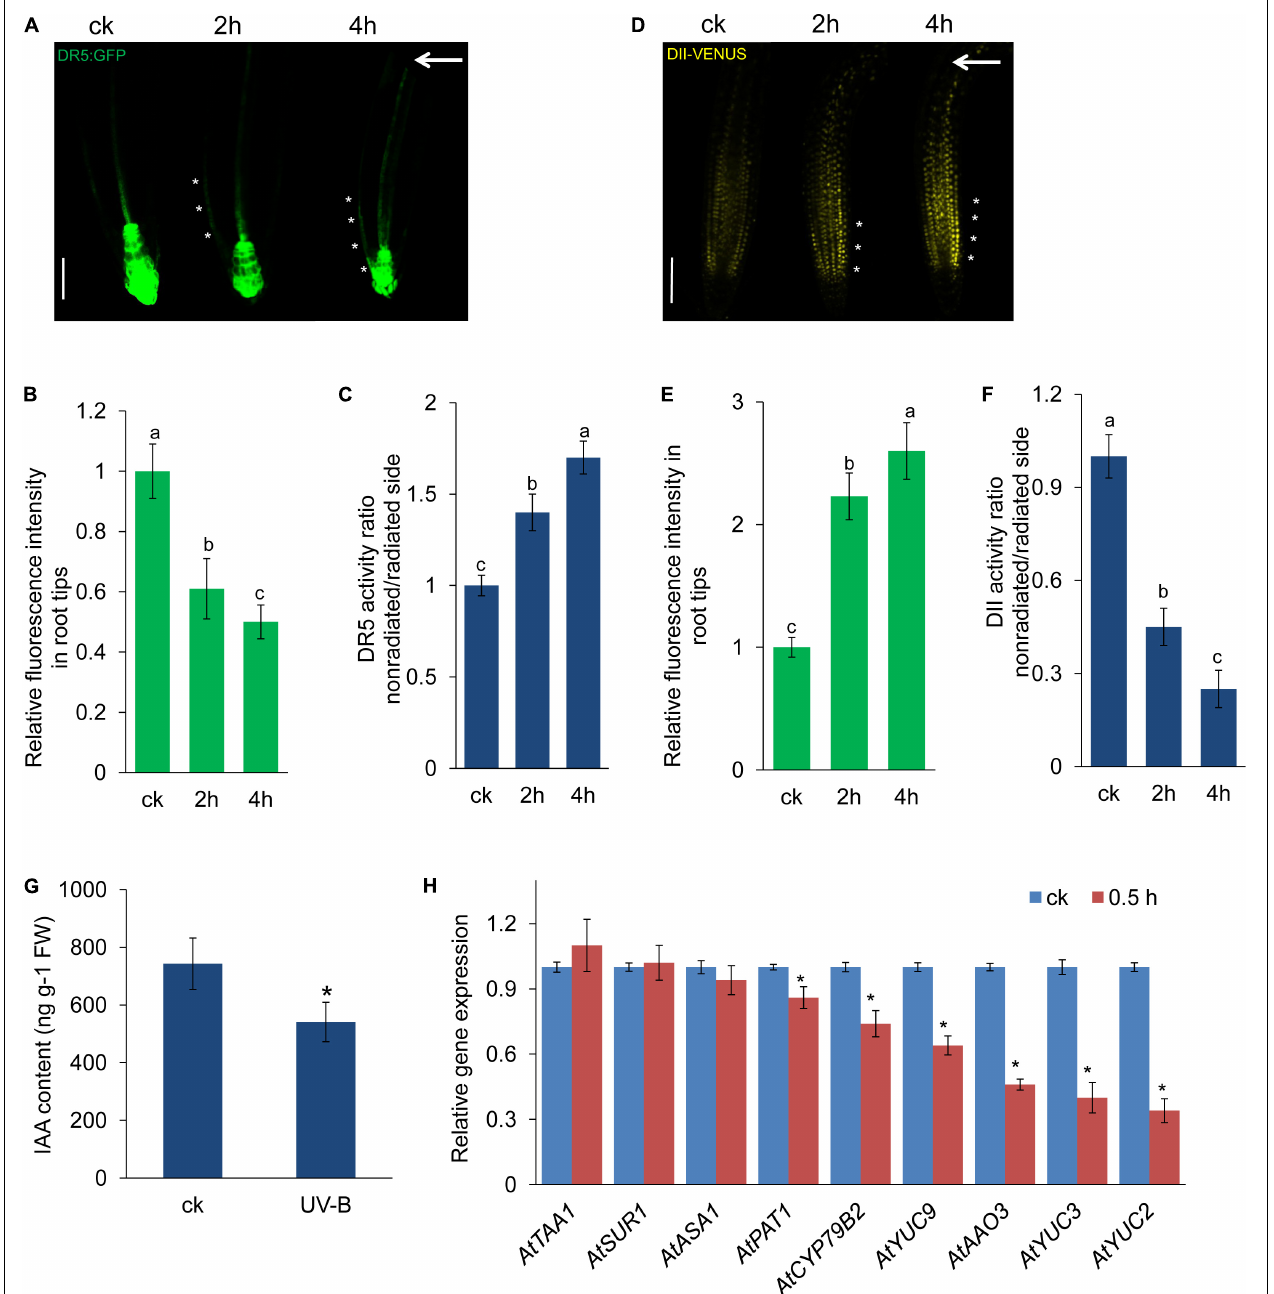
FIGURE 2 | UV-B radiation affects auxin distribution in root tips. (A–F) GFP/YFP fluorescence in the roots of 5-d-old DR5:GFP (A) or DII-VENUS (D) seedlings exposed to UV-B radiation for 1 h and then transferred to normal growth conditions for 2–4 h, quantification of DR5:GFP (B) or DII-VENUS (E) fluorescence intensities in root tips, and ratios of DR5:GFP (C) or DII-VENUS (F) signal in the root tips on the nonradiated side versus the radiated side are shown. Bars, 60 µ m. White arrows indicate the direction of UV-B radiation. White asterisks indicate more pronounced DR5:GFP signals (A) on the nonradiated side of roots or more pronounced DII-VENUS signals (D) on the radiated side; ck, before UV-B radiation control. The error bars represent the ± SE. Different letters indicate significantly different values ( P < 0.05 by Tukey’s test). (G) IAA contents in the roots of wild-type seedlings exposed to UV-B radiation for 1 h and then transferred to normal growth conditions for 2 h. (H) Real-time quantitative reverse transcription-polymerase chain reaction (qRT-PCR) of the expression of auxin biosynthesis-related genes in the wild-type seedlings exposed to UV-B radiation for 1 h and then transferred to normal growth conditions for 0.5 h. The expression levels of the indicated genes in untreated roots (ck) were set to 1. The error bars represent the ± SE. Asterisks ( ∗ ) indicate significant differences with respect to the corresponding control ( P < 0.01 by Tukey’s test).